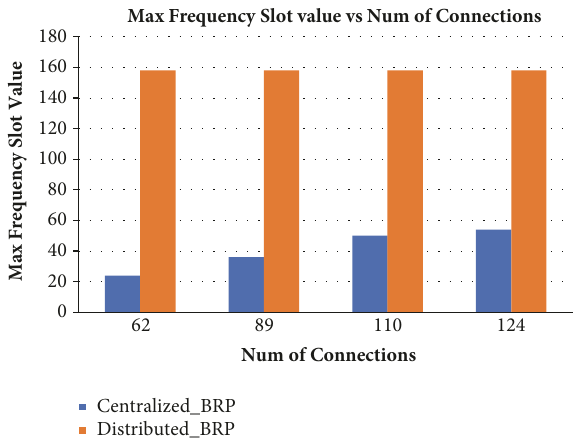
Figure18:Maximumfrequencyslotvaluevsnumberofconnections in Germany topology.